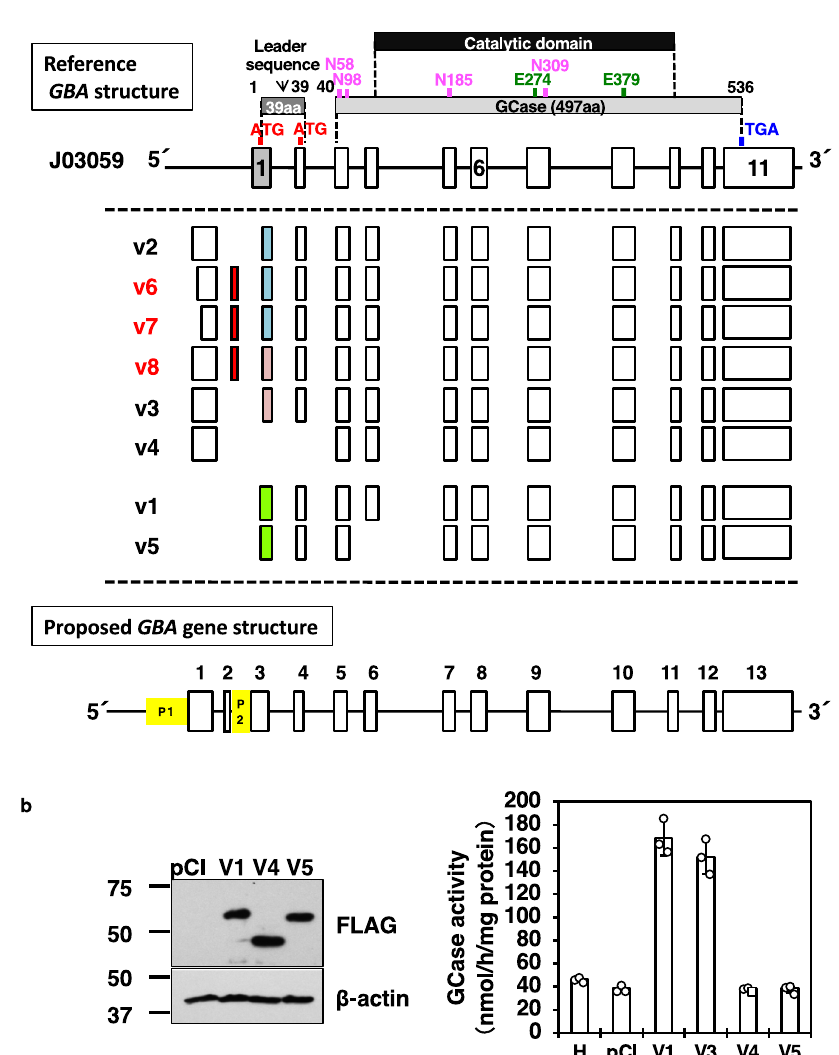
Fig. 1 Determination of the 5 ’ ends of a GBA gene. a Summary cartoon of the 5 ’ ends of all GBA variants. Upper: Exon-intron structures of the reference sequence J03059 and the corresponding translated GCase protein region (gray box) with a catalytic domain (black box). “ ATG ” in red, the start codon, “ TGA ” in blue, the stop codon, “ N ” in pink, glycosylation sites; “ E ” in green, catalytic residues. Middle (within dotted lines): Alignment of the eight variants (vs) with adjusted exon positions compared to J03059. Variant accession numbers are shown in the data availability section. As shown, variants are categorized into two groups: P1-driven variants (v2, v6, v7, v8, v3, and v4) and P2-driven variants (v1 and v5). Red boxes indicate newly identi fi ed exon two. Exon three subdomains are shown in colored boxes (3i, gray; 3ii, green; 3iii, blue; 3iv, pink). Lower: The proposed GBA gene structure. Yellow boxes indicate the P1 and P2 promoter regions. The number above each box indicates the rede fi ned exon number. b GCase protein expression and enzymatic activities of variants v4 and v5. (Left) The GCase protein expression was analyzed using western blot analysis. Representative data is shown. pCI, an empty vector-transfected HEK293 cell lysate; V1, V4, V5, each variant overexpressed HEK293 cell lysate. (Right) GCase activity of each variant transfected HEK293 cells. H, control HEK293 cells (no treatment); V3, variant v3 in pCIneo-transfected cells; others, similar to the right panel. n = 3 biologically independent samples. Data represent the mean ±